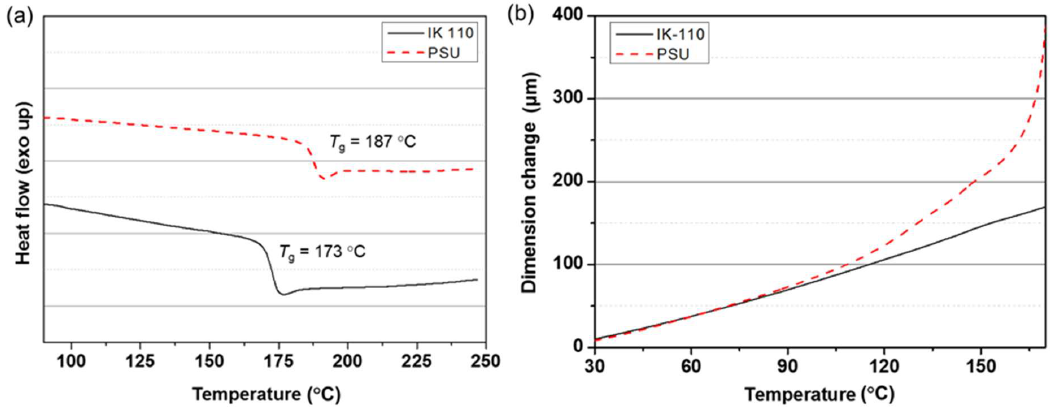
Figure 6. ( a ) DSC and ( b ) CTE curves of IK-110 and PSU films.